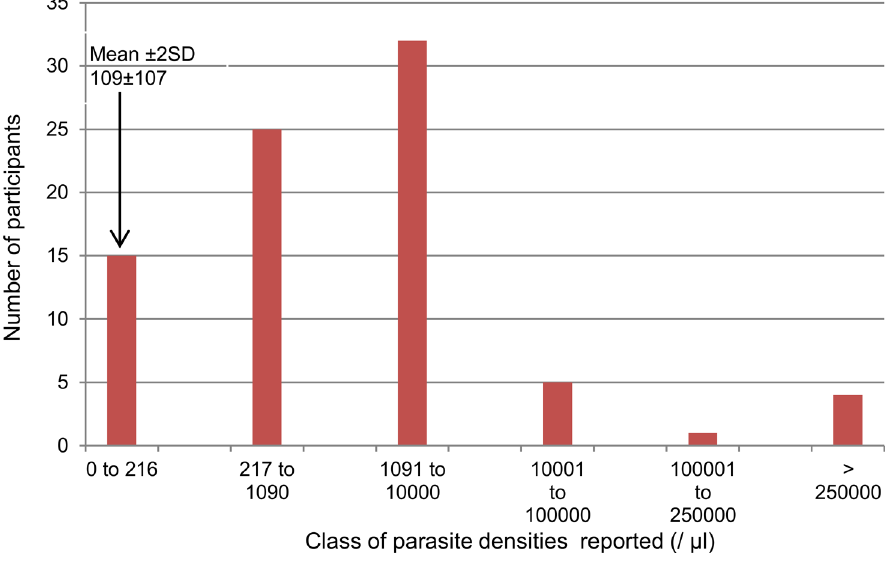
Fig 2. Distribution of parasite densities expressed per μ l of blood (n = 82) for slide 3. The bar “ 0 – 216 ” represents parasite densities within 2 SD, the bar “ 207 – 1090 ” represents parasite densities within 10 x the mean value and the rest represent the densities > 10 x the mean